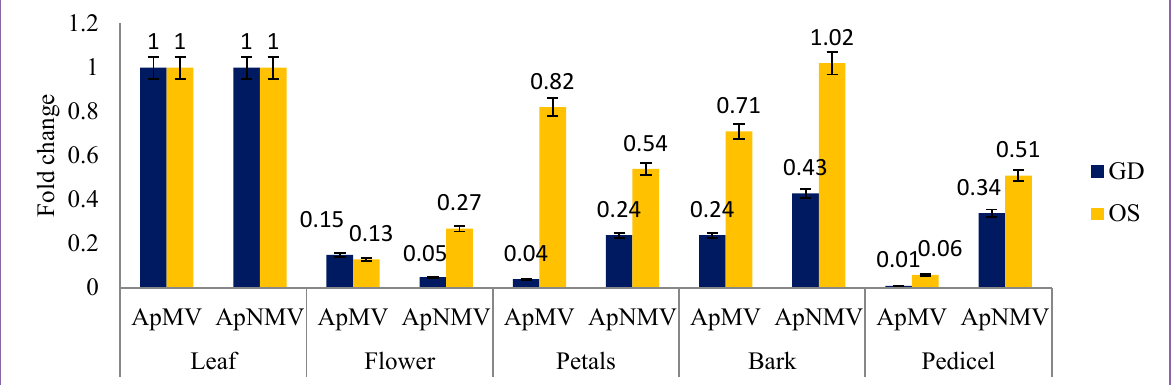
Figure 5. Comparative fold change ofthe CP gene of ApMV and ApNMV in different tissues in cultivar Golden Delicious (GD) and Oregon spur (OS) during the spring season. Y -axis represents the fold change in the viral infection, whereas X -axis represents different tissues tested for both viruses.